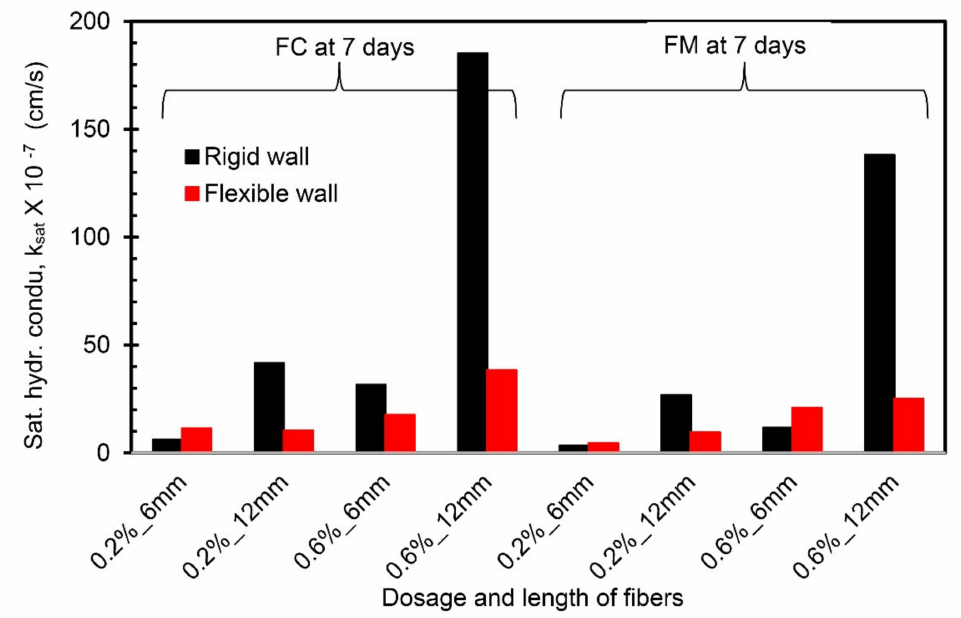
Figure 10. Comparison of hydraulic conductivity values from FWP and RWP (7-day curing period).